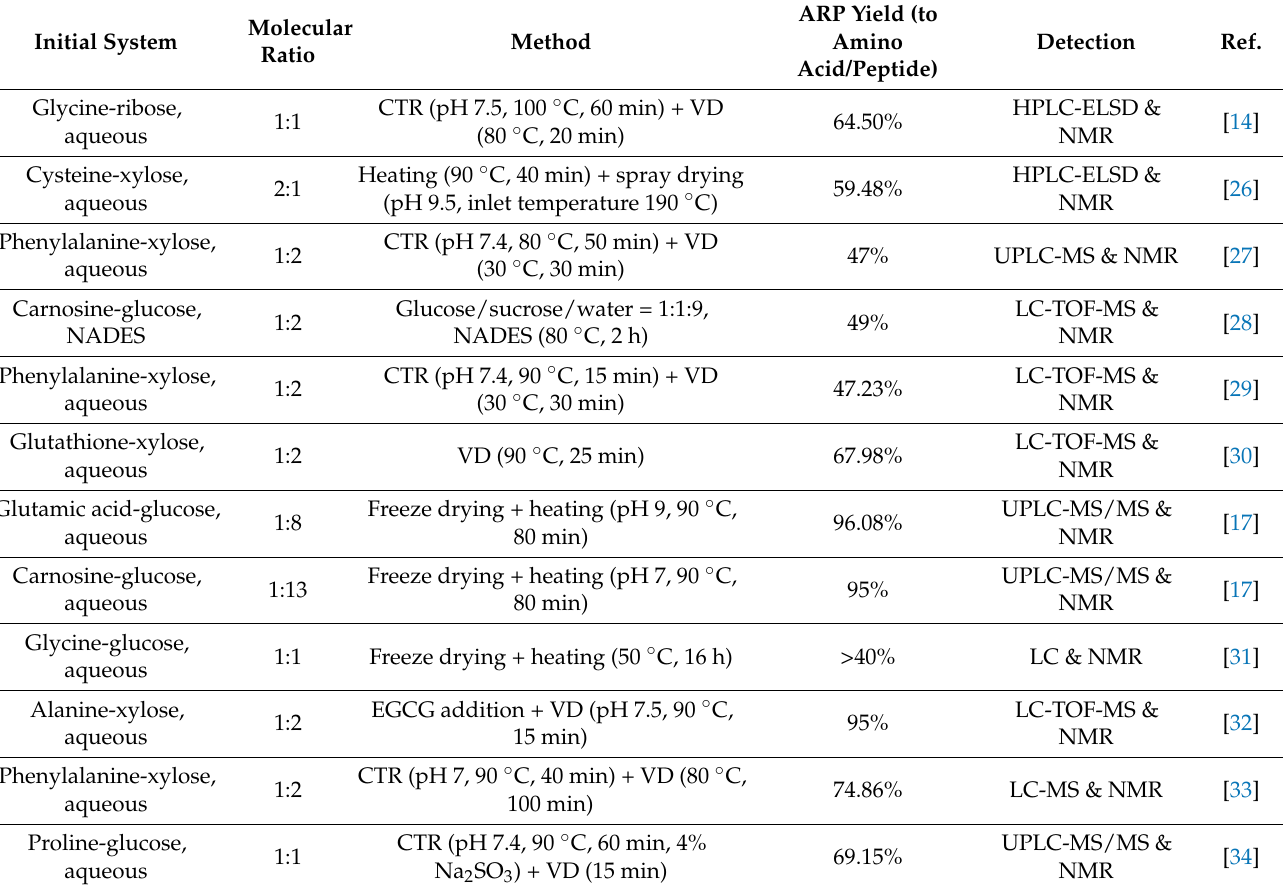
Table 1. Recent application of LC-MS on ARP detection and improvement of ARP